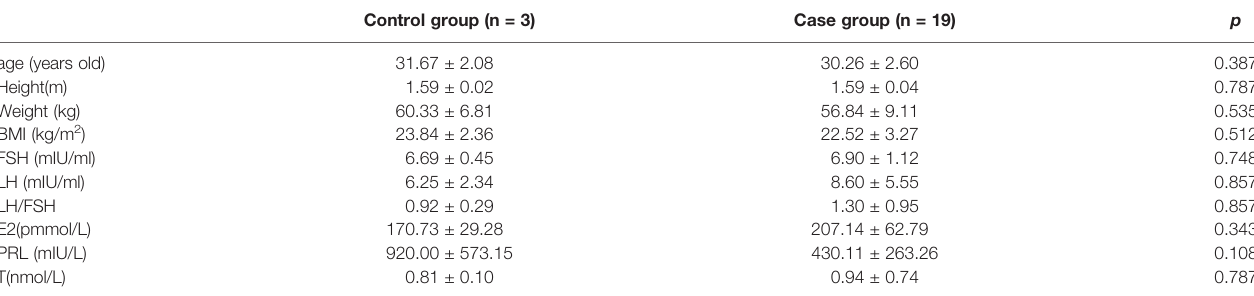
TABLE 2 | Comparison of basic clinical characteristics between case and control